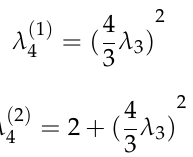
Figure 8. Relationship between skewness and kurtosis from intermediate to shallow water regions before and after the toe of the slope. The solid black line represents the second ‐ order nonlinear the ‐ ory with respect to water depth change [40]. The solid blue line depicts an adjusted formula intro ‐ duced by the data found in the sloping bottom.